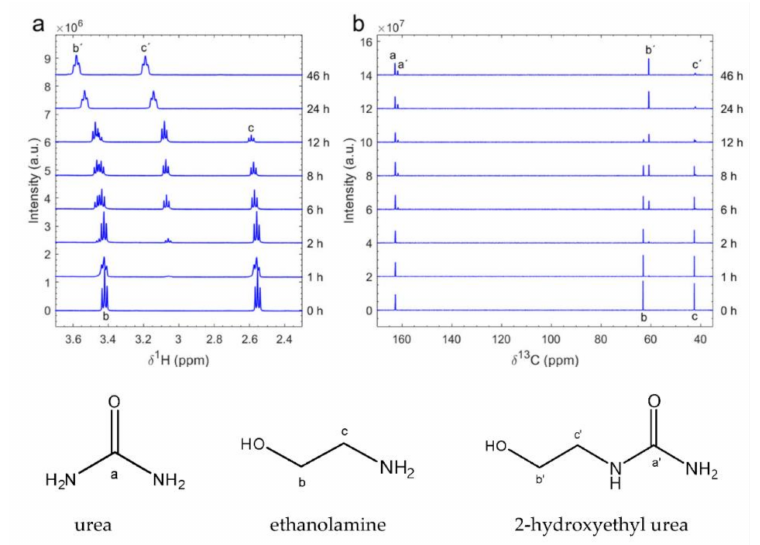
Figure 1. ( a ) 1 H NMR spectra and ( b ) 13 C NMR spectra of the formation of 2-hydroxyethyl urea from ethanolamine and urea. The reaction was conducted at 80 ◦ C with 5% v/v of ethanolamine in H 2 O/D 2 O and an ethanolamine/urea ratio of 1:6. The times on the right of each spectrum indicate the reaction time. Spectra are offset vertically for clarity. Note that the 13 C peak for c’ is broadened significantly, hence the lower peak